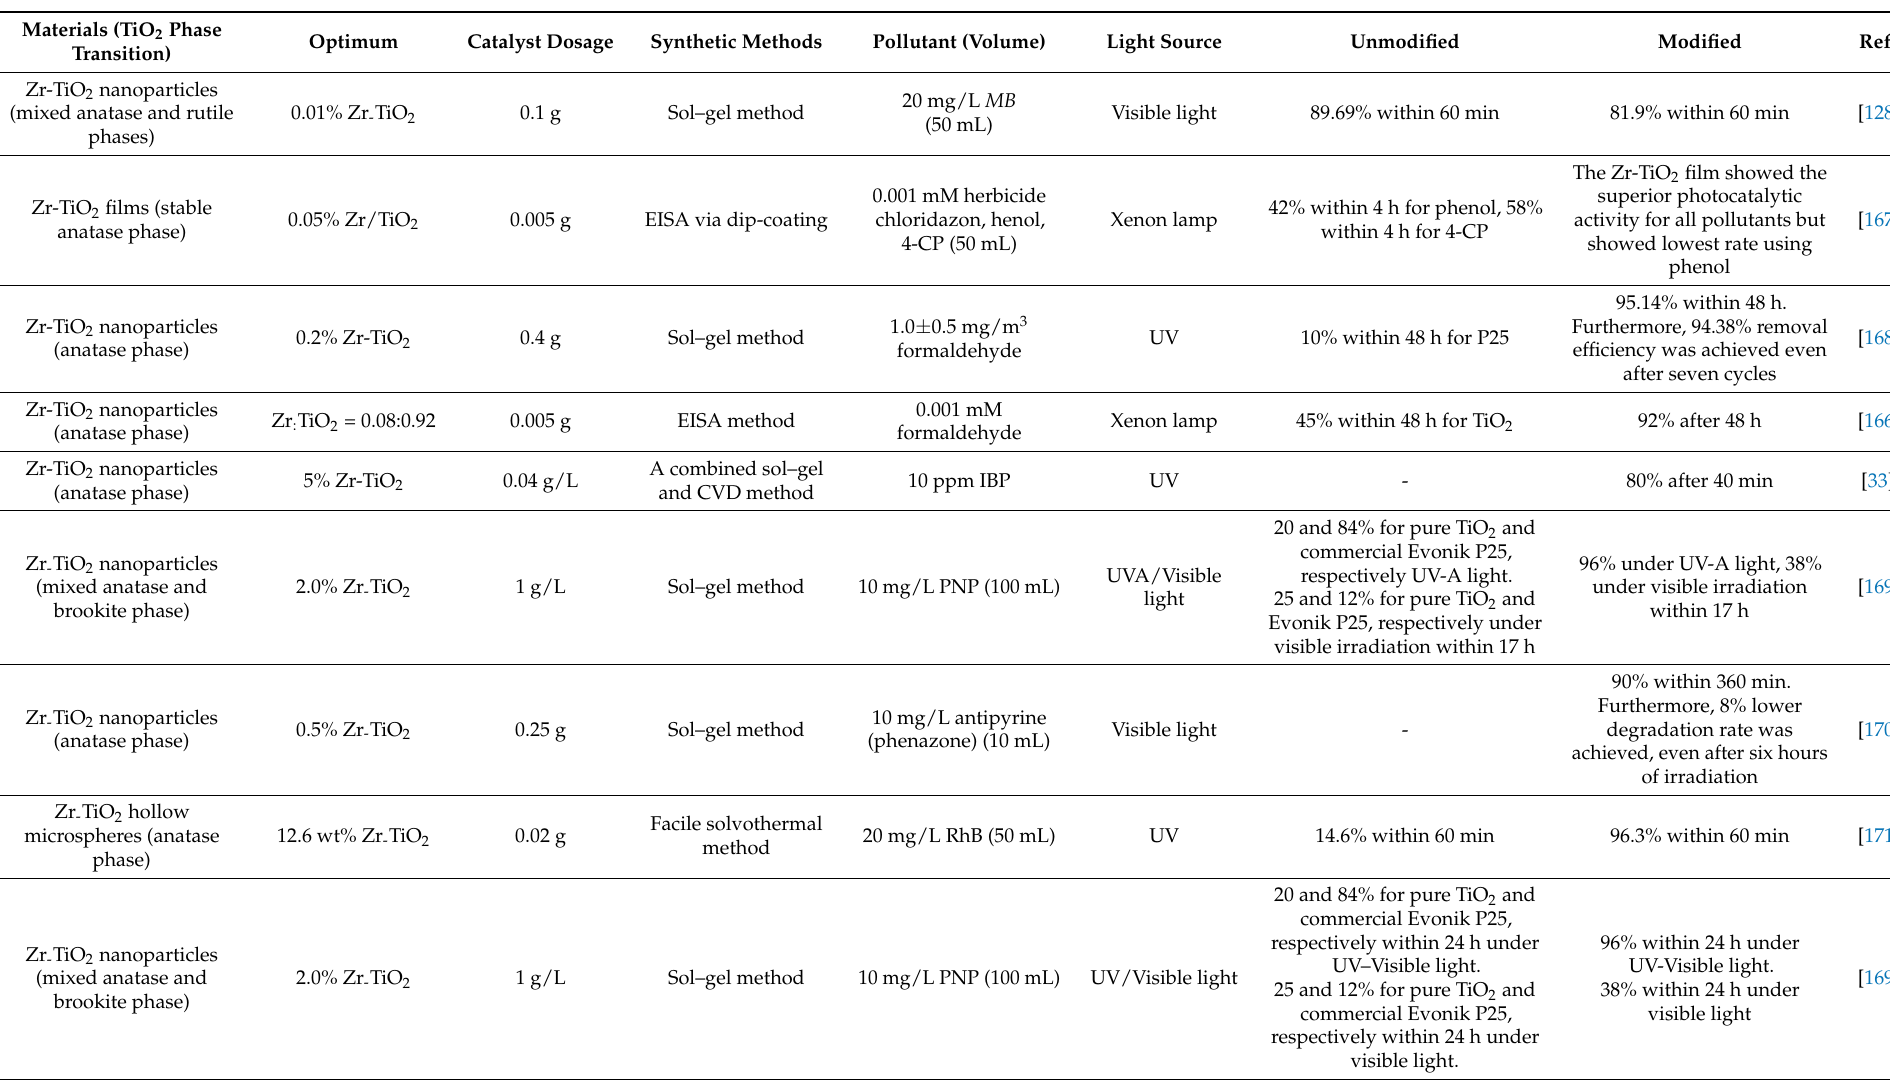
Table 7. Summary of recent progress on Zr-TiO 2 photocatalysts for organic pollutants